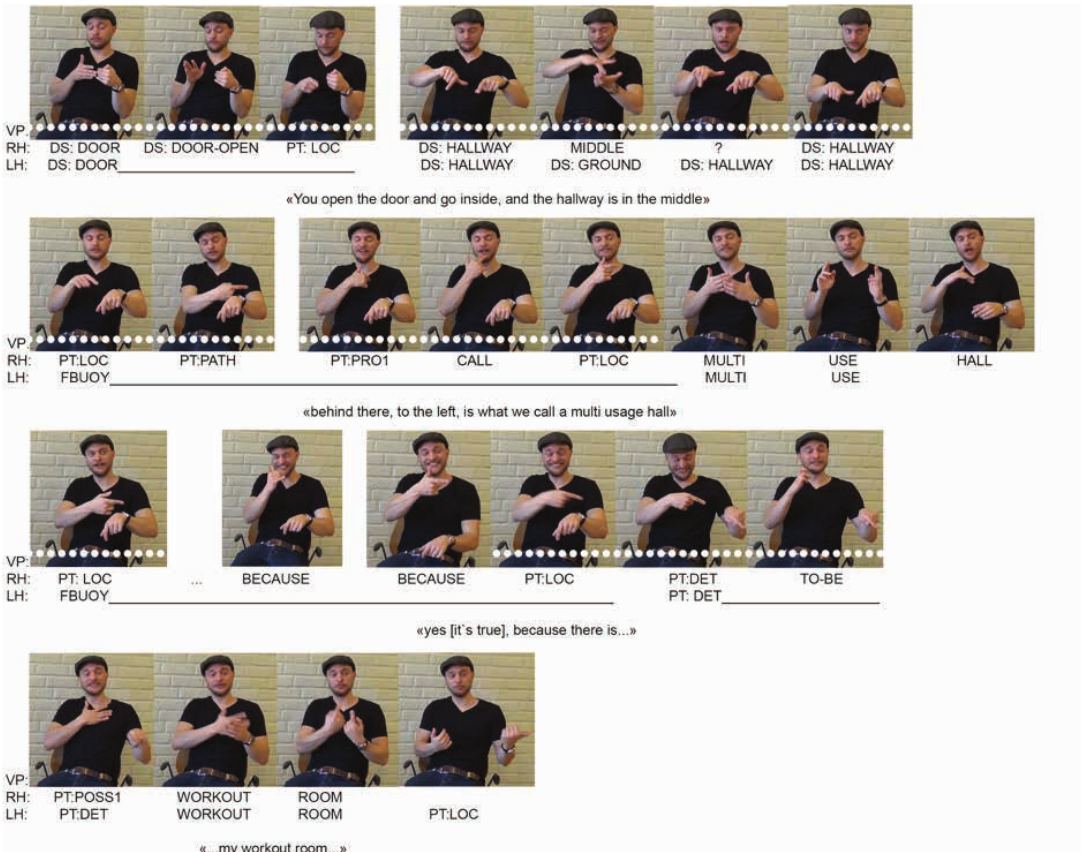
Figure 3: A signer depicting his apartment from an external, static vantage point (DPNTS_O_PN.eaf,